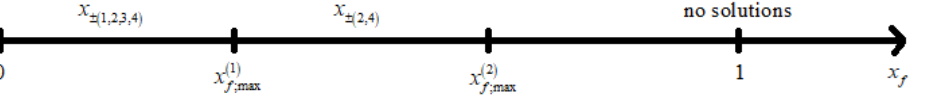
Figure 2. The regions of the scattered electron energy and the possible energies of the particles of the pair in these regions (see Inequalities (27) and